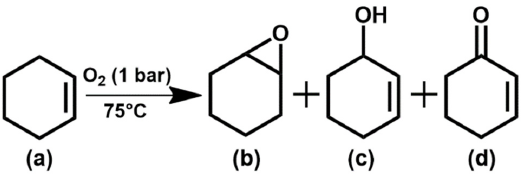
Table 3. Catalytic results after 24 h of the aerobic oxidation of cyclohexene at 75 °C using LaMODA (M=Co II , Cu II